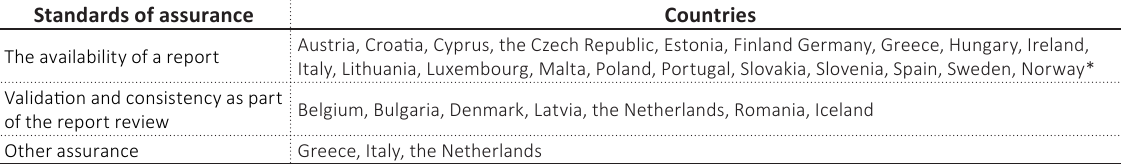
Table 1. National approaches to the transposition of EU Directives on the audit of a management report by member